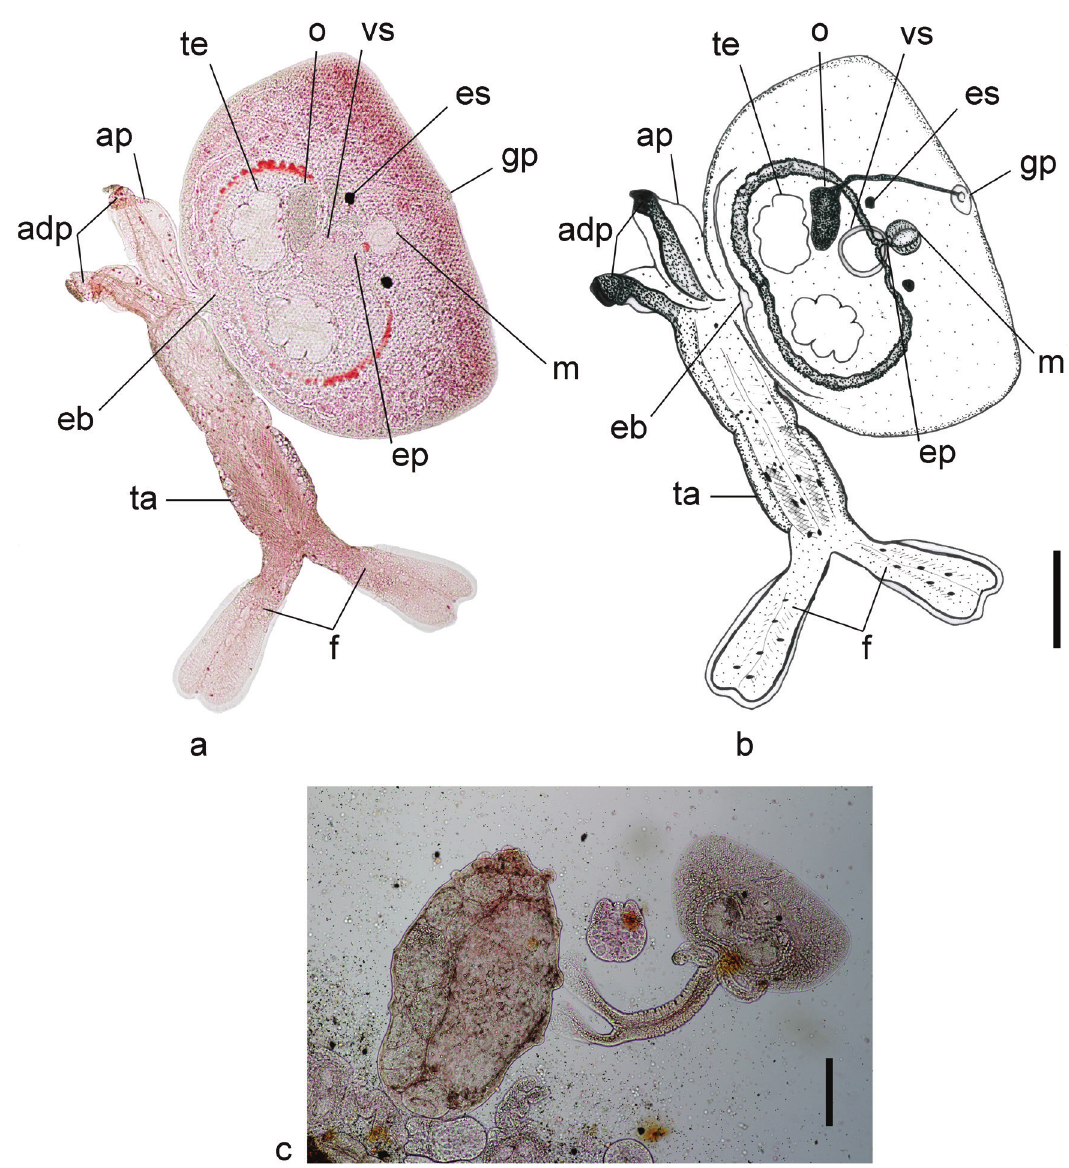
Figure 15. Transversotrema laruei Velasquez, 1958. a . specimen stained with 0.5% neutral red. b . drawing of cercaria. c . redia (left) and cercaria (right) stained with 0.5% neutral red. Abbreviations – adp: adhesive pad; ap: appendages; eb: excretory bladder; ep: esophagus; es: eyespot; f: furca; gp: genital pore; m: mouth; ov: ovary; ta: tail; te: testes; vs: ventral sucke. Scale bars: 50